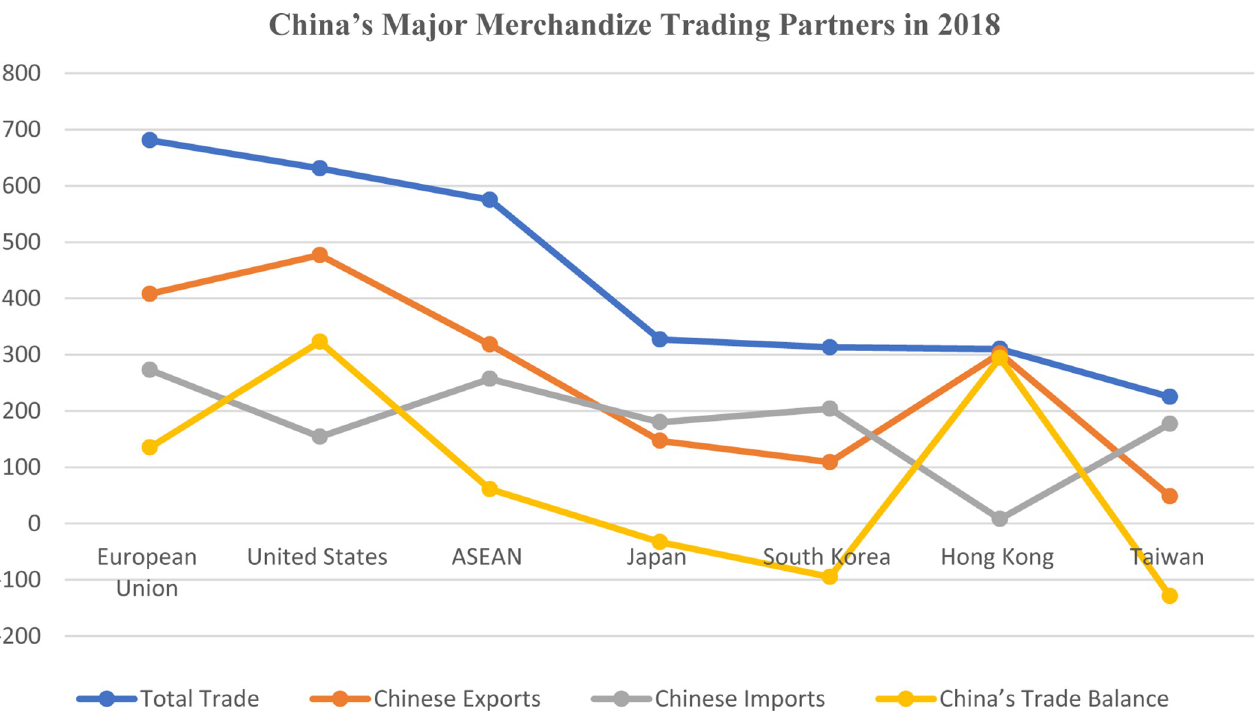
Fig 1. China’s major merchandize trading partners in 2018. According to trade statistics, the United States, the EU, and ASEAN were China’s top three export markets, while the EU, ASEAN, and South Korea were its main import sources. China has large trade surpluses with the US ($282 billion), Hong Kong ($274 billion), and the European Union ($129 billion), but large trade deficits with Taiwan ($112 billion) and South Korea ($74 billion). However, China’s trade statistics differ greatly from those of the United